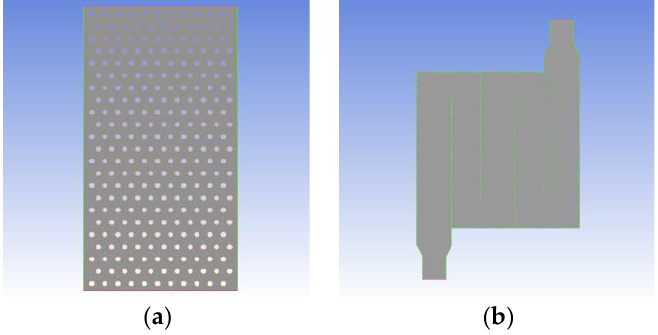
Figure 3. The two dimensional grids of the cold fluid ( a ) and thermal fluid ( b ).